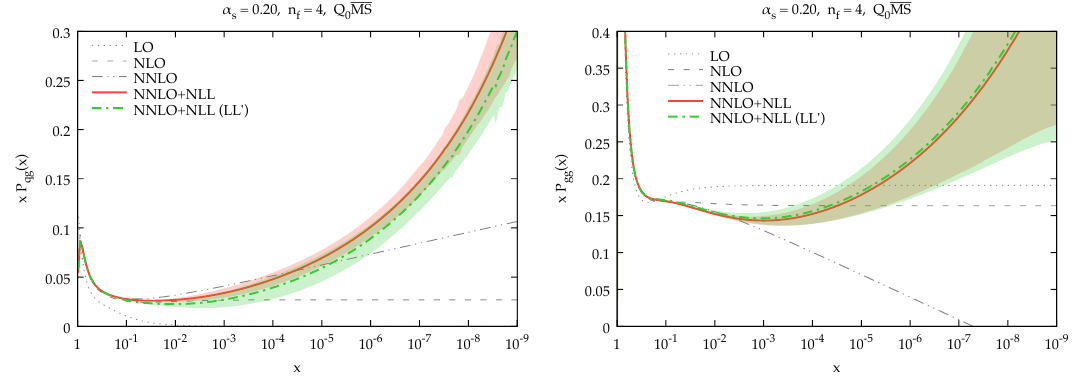
Figure 2 . Comparison between resummed and matched splitting functions in two variants of small- x